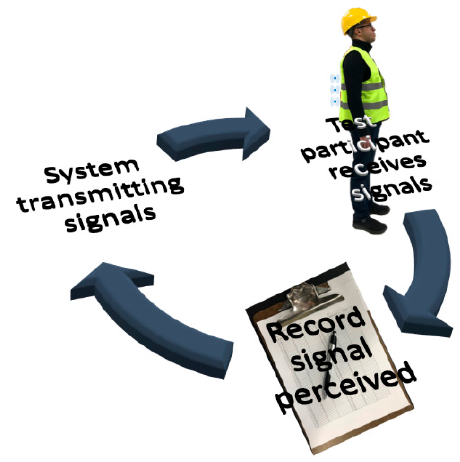
Figure 4. General experimental procedure.